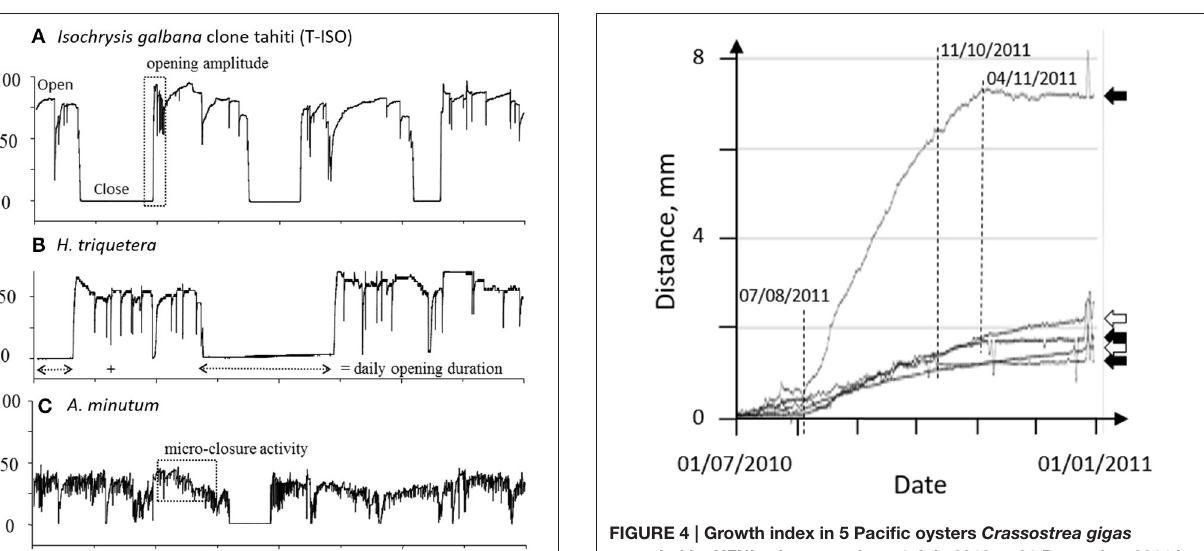
FIGURE 4 | Growth index in 5 Pacific oysters Crassostrea gigas recorded by HFNI valvometry from 1 July 2010 to 31 December 2011 in the Bay of Arcachon, France. The index corresponds to the minimum daily opening value measured between HFNI electrodes as shown in Figure 1 . White arrows, 2 oysters with continuous growth; black arrows, 3 oysters exhibiting a growth arrest which started during the period 11 October – 4 November 2011 (dashed lines), at the beginning of the winter period. Note the growth rate acceleration that started in early August. hippopus , the Pacific oyster Crassostrea gigas ( Figure 3 ) and the Icelandic scallop Chlamys islandica at their natural